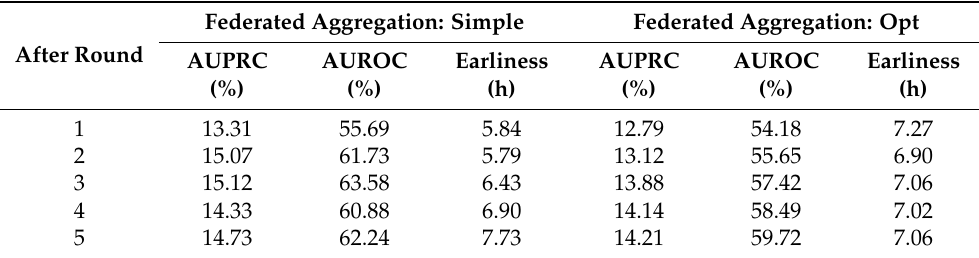
Table 13. Evaluation results using clinical-text input features in a federated learning setting using three Jetson Nano devices.